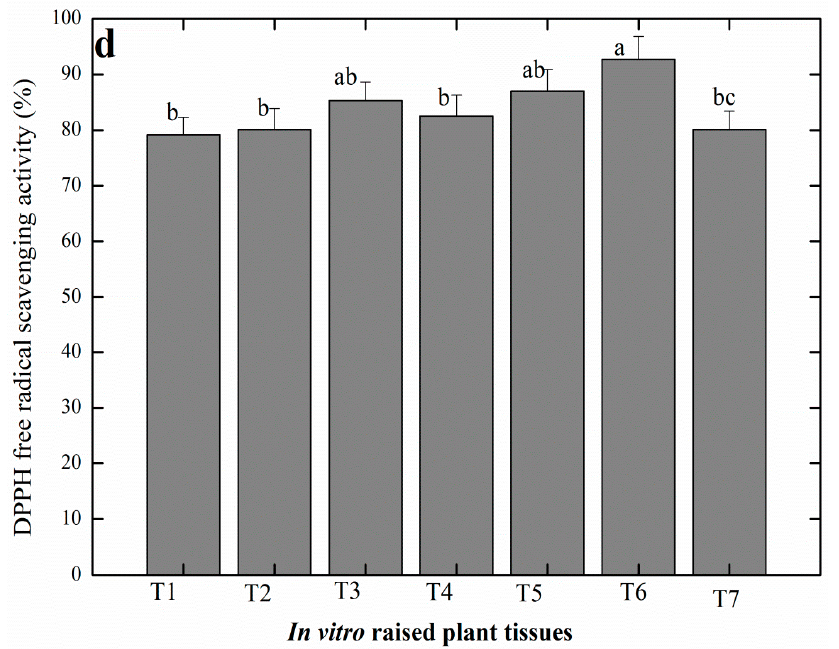
Figure 2. Estimation of the accumulation of antioxidant secondary metabolites in the micropropagated shoots of L. usitatissimum in response to di ff erent PGR treatments. ( a ): total phenolic content (TPC), total flavonoid content (TFC) and phenyl alanine ammonia lyase (PAL) activity, ( b ): superoxide dismutase (SOD) activity, ( c ): peroxidase (POD) activity, and ( d ): DPPH free radical scavenging activity. T1: 0.5 mg / L TDZ, T2: 1.0 mg / L TDZ, T3: 1.5 mg / L TDZ, T4: 0.5 mg / L Kn, T5: TDZ + Kn (0.5 mg / L, each), T6: 1.0 mg / L TDZ + 0.5 mg / L Kn, and T7: 1.5 mg / L TDZ + 0.5 mg / L Kn. Values represent mean data of each treatment with ± standard error. Di ff erent letter(s) on each column data is statistically significant at p ≤ 0.5.